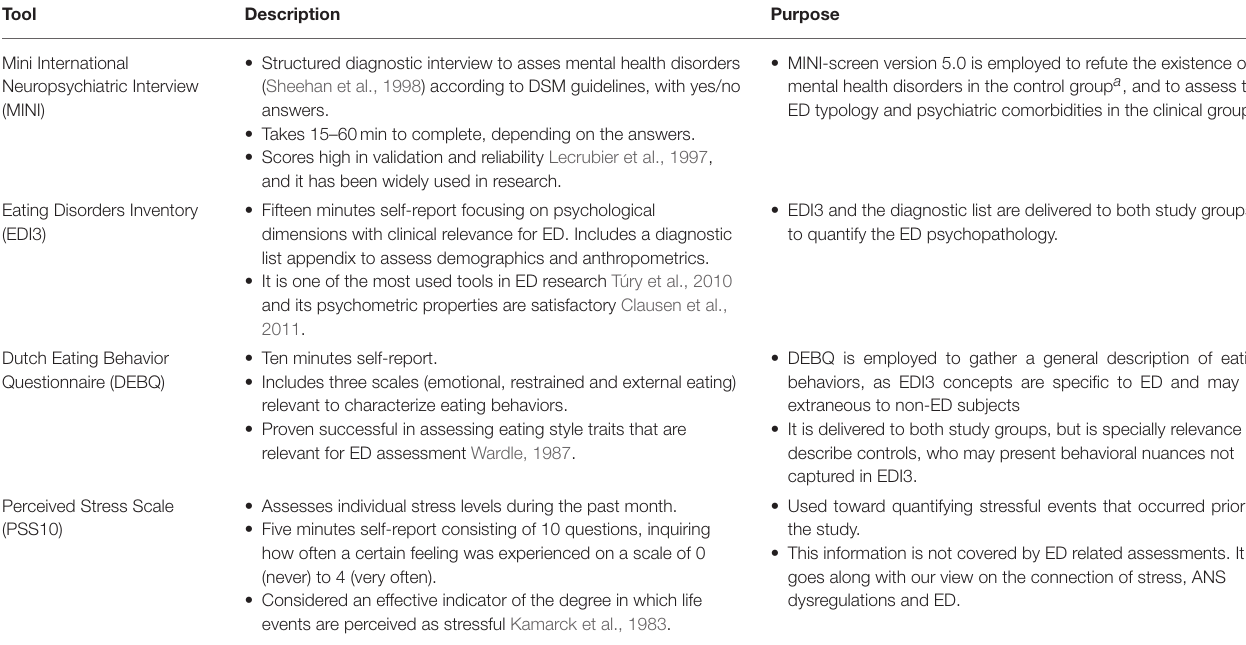
TABLE 3 | Description of standardized psychometric tools and their purpose in our study context.